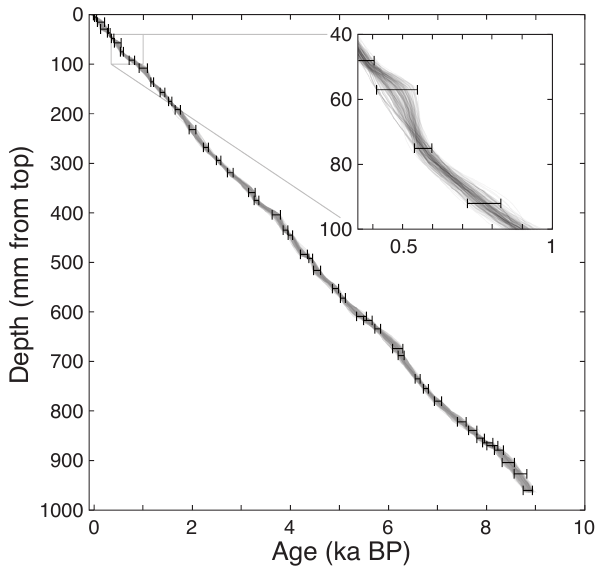
Figure 3. Exemplary depth–age model for the Dongge DA record (Wang et al., 2005) represented as an ensemble of 1000 different chronologies. The inset shows an enlarged view of a specific time interval illustrating the spread of depth–age models due to dating uncertainties. Discrete dating points are indicated by black dots, while the associated 2 σ dating uncertainties are displayed by error